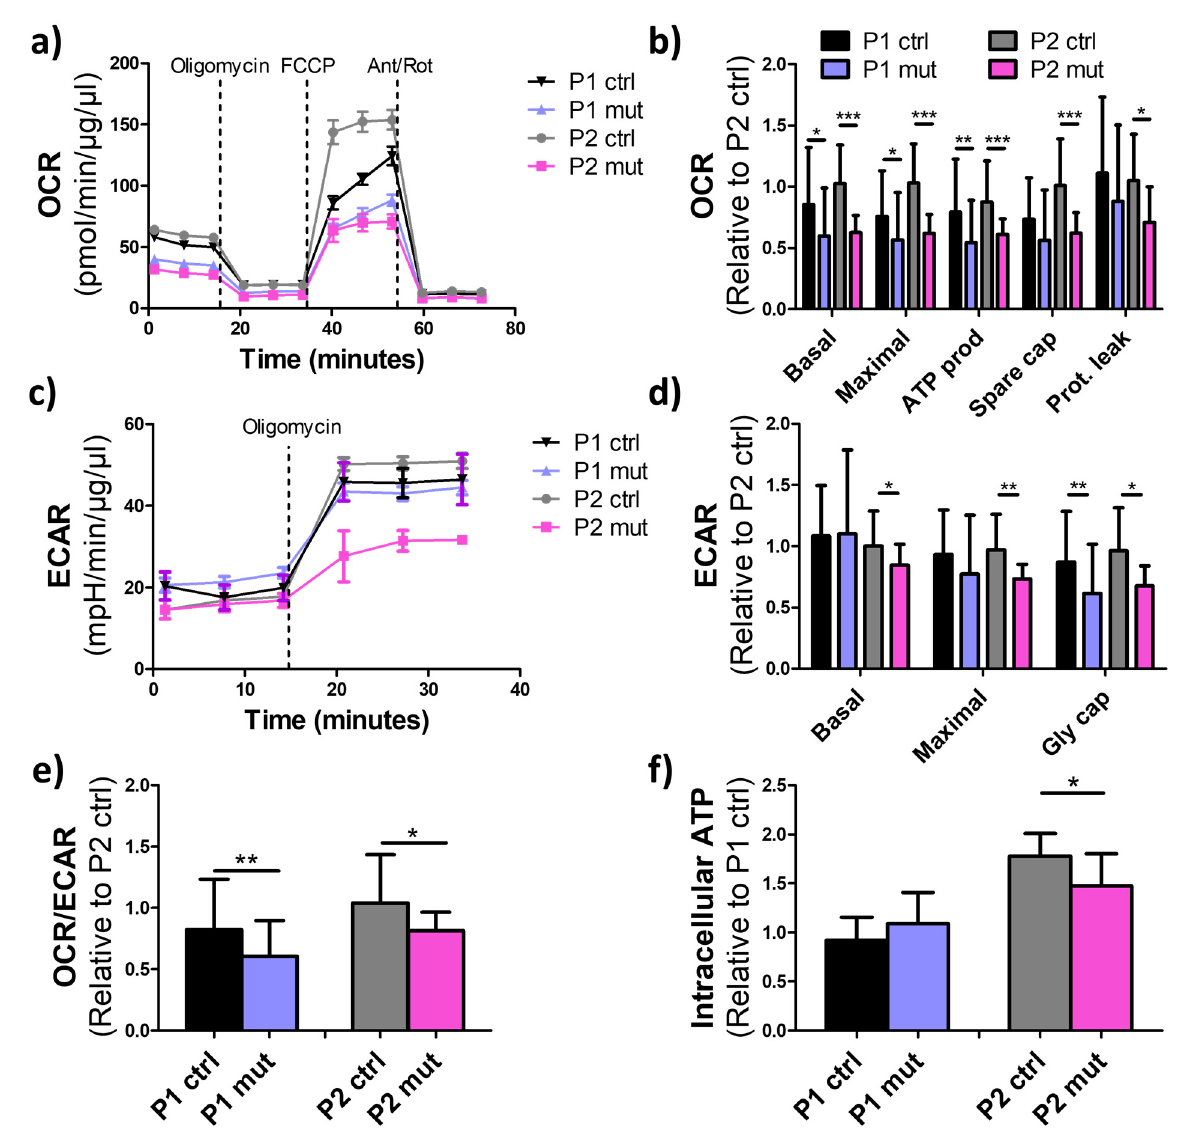
Figure 3. Mitochondrial respiration is decreased in patient cardiomyocytes upon a high mutation load. ( a ) Oxygen consumption rates (OCR) at basal level and after inhibition of the RC with oligomycin (CV inhibitor), FCCP (uncoupling agent), and Antimycin A (CIII inhibitor) and Rotenone (CI inhibitor) (Ant/Rot). Data is normalized to total protein content. Respiratory activity is reduced in mutant cells of both patients. ( b ) Analysis of the OCR data relative to one P1 ctrl line. Prot. Leak = Proton leak. ( c ) Extra Cellular Acidification Rates (ECAR) at the basal level and after inhibition of mitochondrial ATP synthesis with oligomycin, data normalized to total protein content. The ECAR is reduced in mutant cells of P2, indicating reduced glycolytic activity. ( d ) Analysis of the ECAR data relative to one P2 ctrl line. Gly cap = glycolytic capacity. ( e ) OCR/ECAR ratios representing relative oxidative activity calculated at basal level and relative to one P2 ctrl line. ( f ) Intracellular ATP levels in iPSC-CMs measured with ATPlite assay. Relative to one P1 ctrl line. Cellular ATP levels are reduced upon a high mutation amount in P2 cells. * p < 0.05 ** p < 0.01 *** p < 0.001. All results are shown as mean +/-SD and calculated from three independent experiments. Mitochondrial respiration analysis: P1 ctrl n = 36, P1 mut n = 38, P2 ctrl n = 74, P2 mut n = 14; ATPlite assay: P1 ctrl n = 20, P1 mut n = 13, P2 ctrl n = 15, P2 mut n = 28.